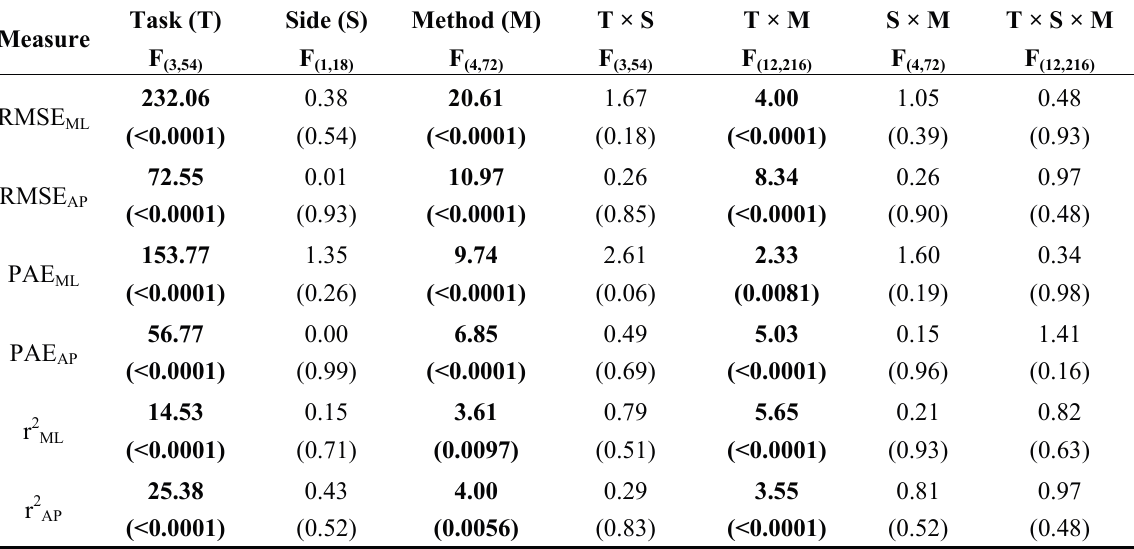
Table 1. Summary of ANOVA results ( F value ( p )) for the main and interaction effects of Task , Side , and Method on each comparative measure (significant effects are in